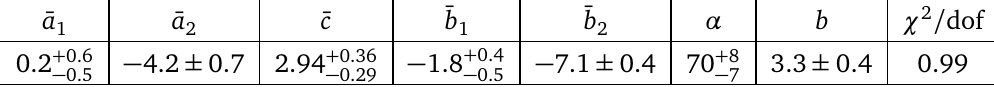
]= GeV − 2 , [ ¯ b ]= GeV − 4 , i j